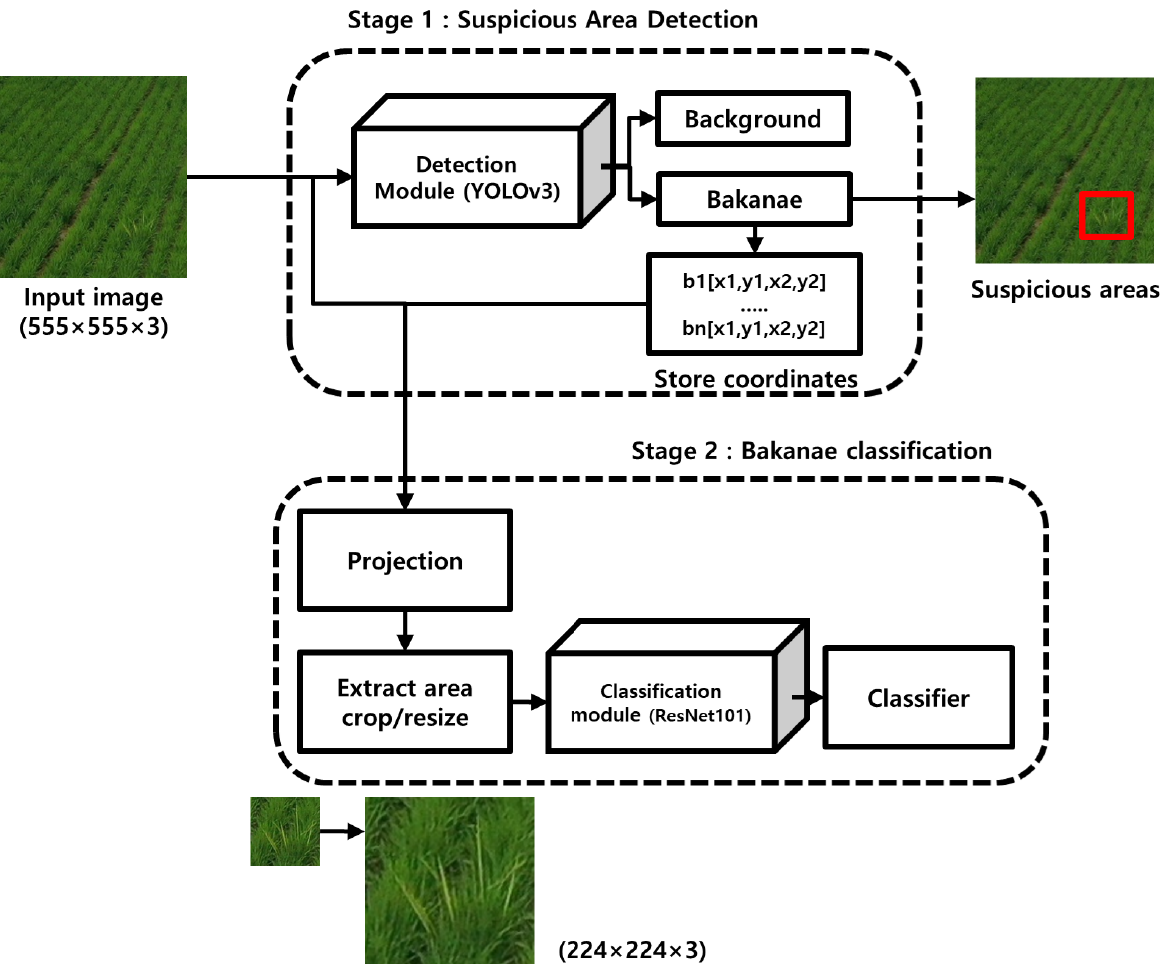
Figure 9. The process of determining the number of RBD-infected culms.